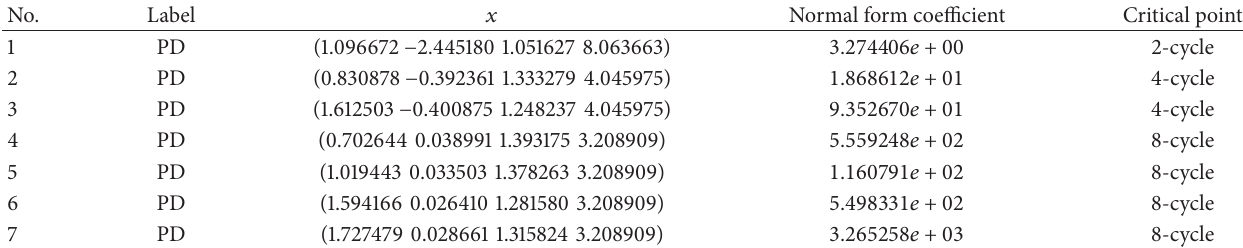
Table 2: Numerical continuation of 𝐸 1 with control parameter 𝑠 2 as shown in Figure 5.